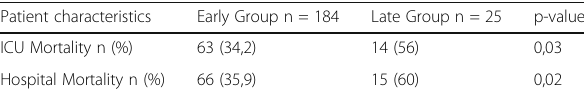
Table 1 (abstract 0391). Mortality Rates according to early antibiotic adequacy